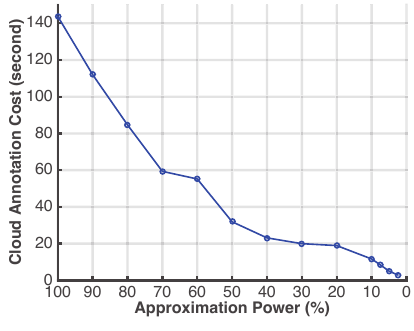
Figure 7. Privacy-preserving Annotation Cost on Cloud with Different Approximation